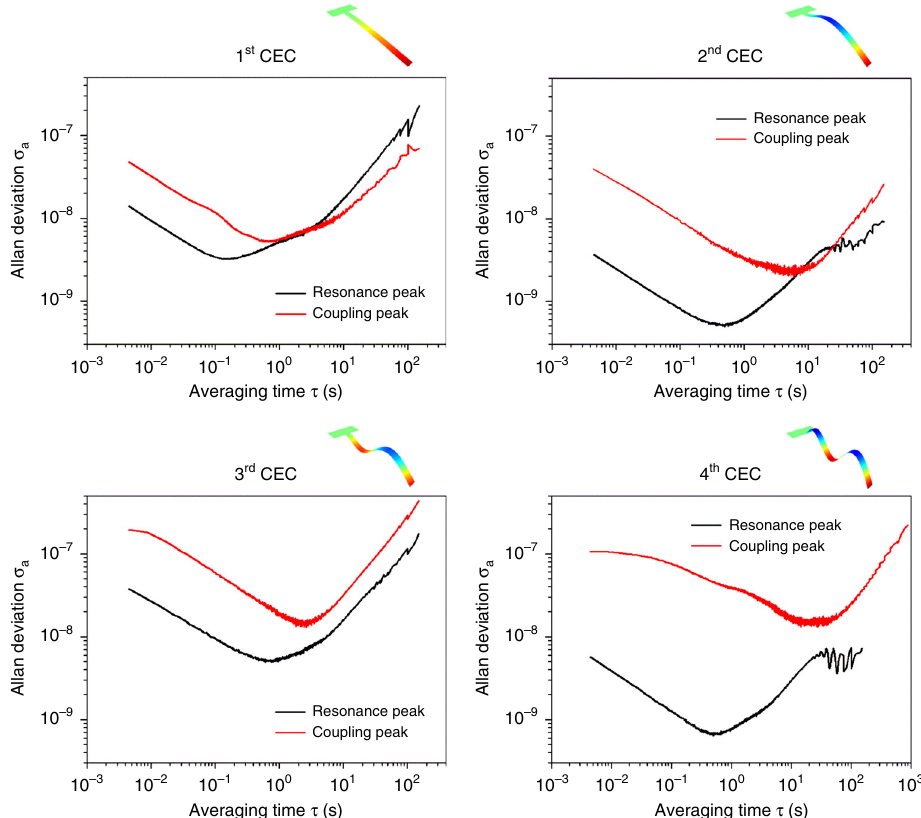
Fig. 2 Frequency stability of Lorentzian resonance and weak-coupling peaks. Measured Allan deviations for the fi rst four cantilever modes (as a function of averaging time); each of these modes is referred to as a collective eigenmode class (CEC) below. Results are reported for the amplitude of the primary Lorentzian peak and one weak-coupling